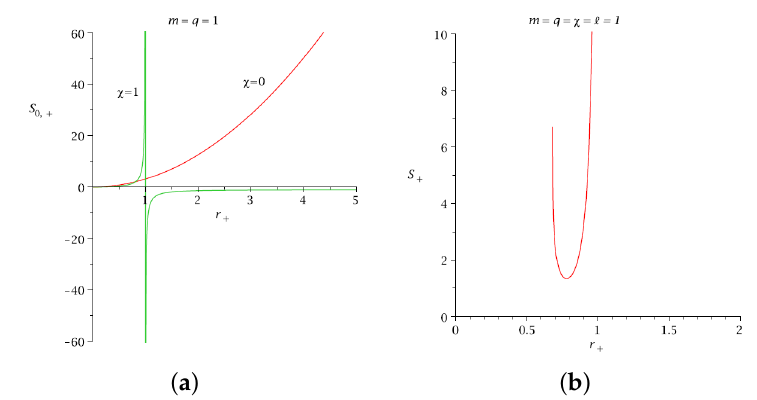
Figure 3. In this graph, we have drawn the variation of logarithmic corrected entropy ( S + ) ( a ) and without logarithm corrected entropy ( S 0, + ) ( b ) with horizon radius ( r +